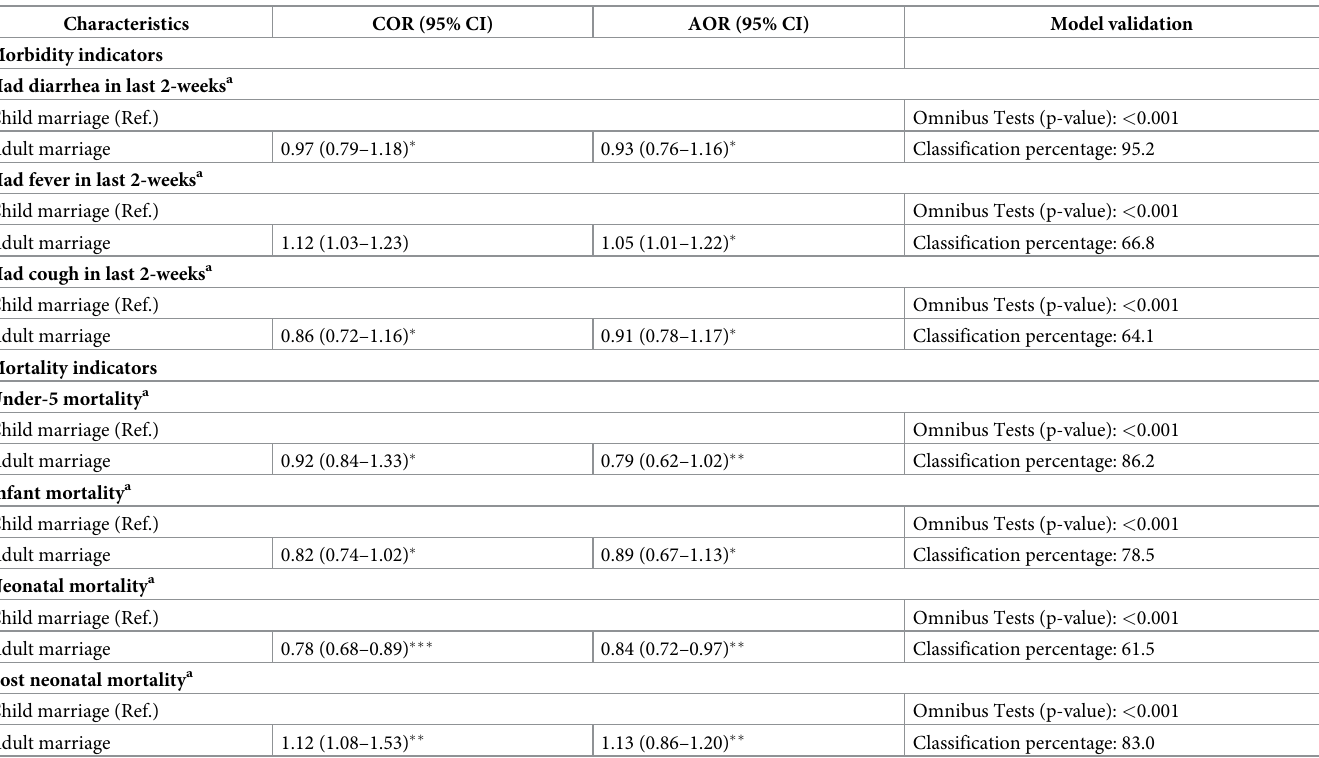
Table 3. Impact of child marriage ( < 18 years old) on morbidity and mortality of under-5 children in Bangladesh; BDHS-2017-18. Characteristics